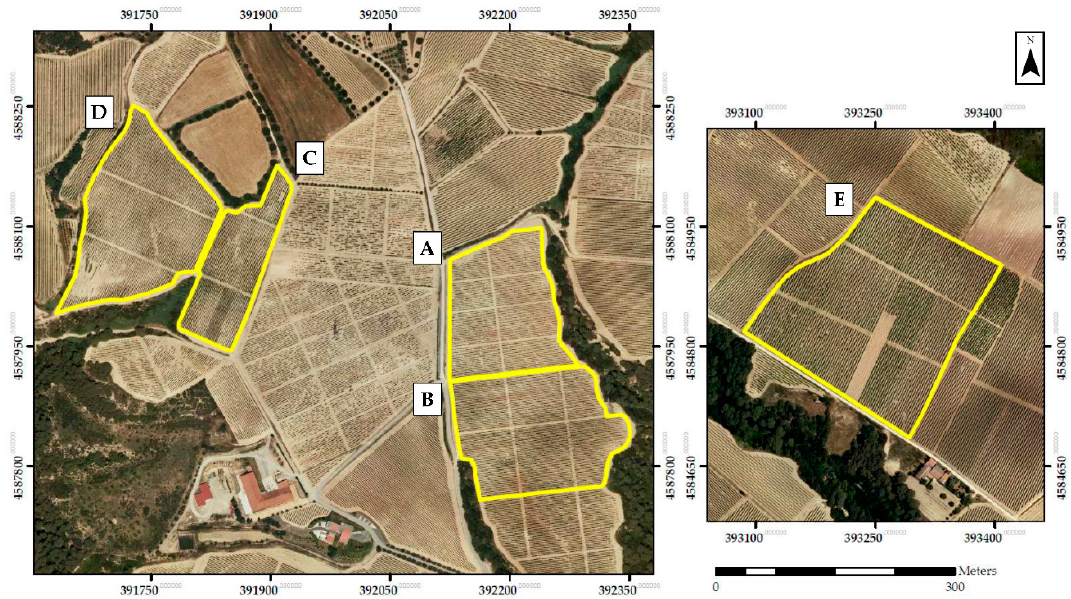
Figure 1. Orthophotomaps of studied vineyard plots.